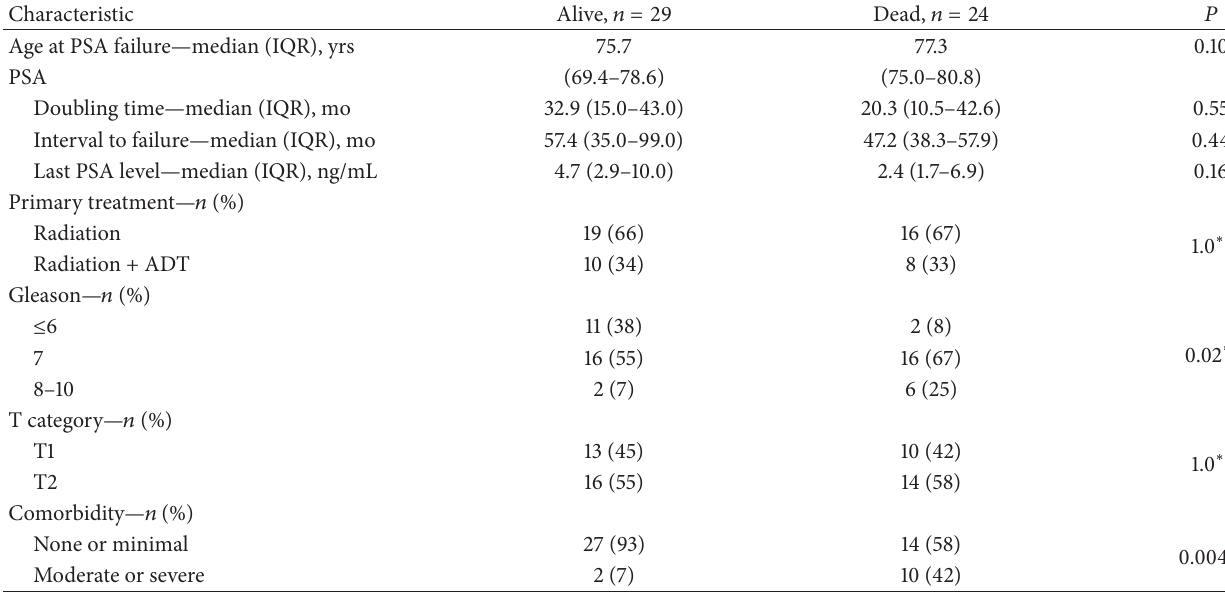
Table 1: Comparison of the distribution of the clinical characteristics at the time of initial treatment and at PSA failure for the 53 men in the study cohort stratified by survival status at time of last